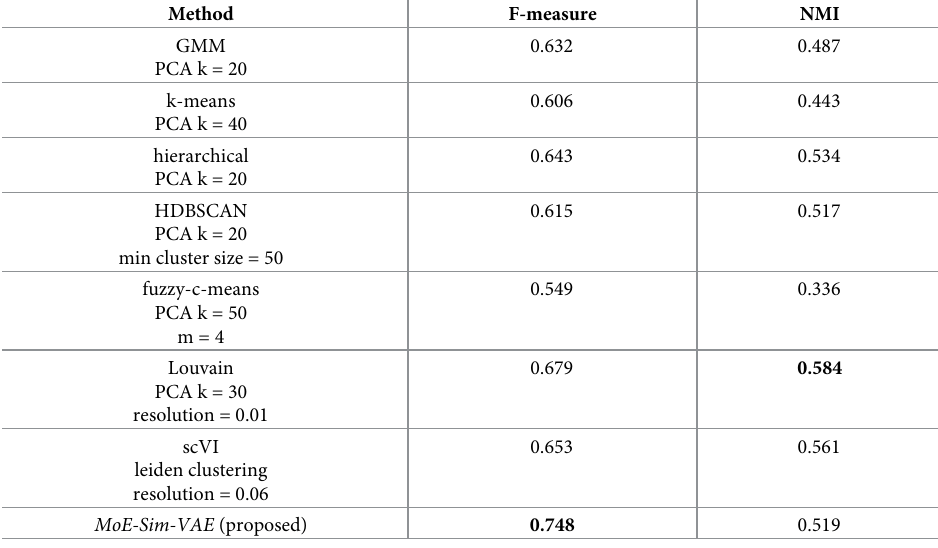
Table 2. Results on clustering mouse organs based on RNA-seq. We compare MoE-Sim-VAE to the competitor methods Gaussian Mixture Models (GMM), k-means, Hierarchical clustering, DBSCAN, FCM and Louvain clustering.